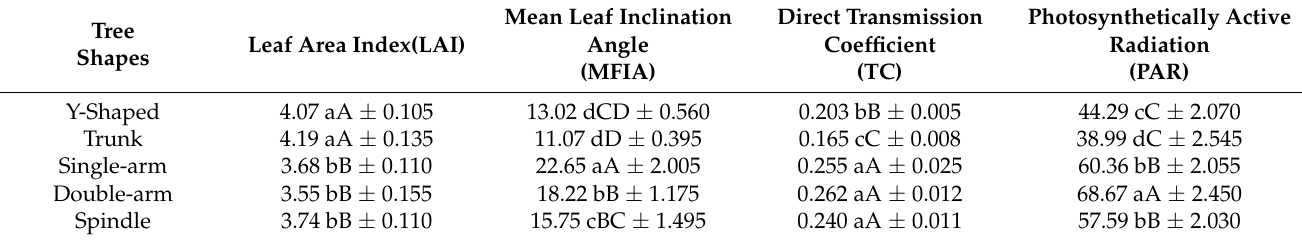
Table 2. Comparison of the canopy structure indices of Zaosu pear trees with different